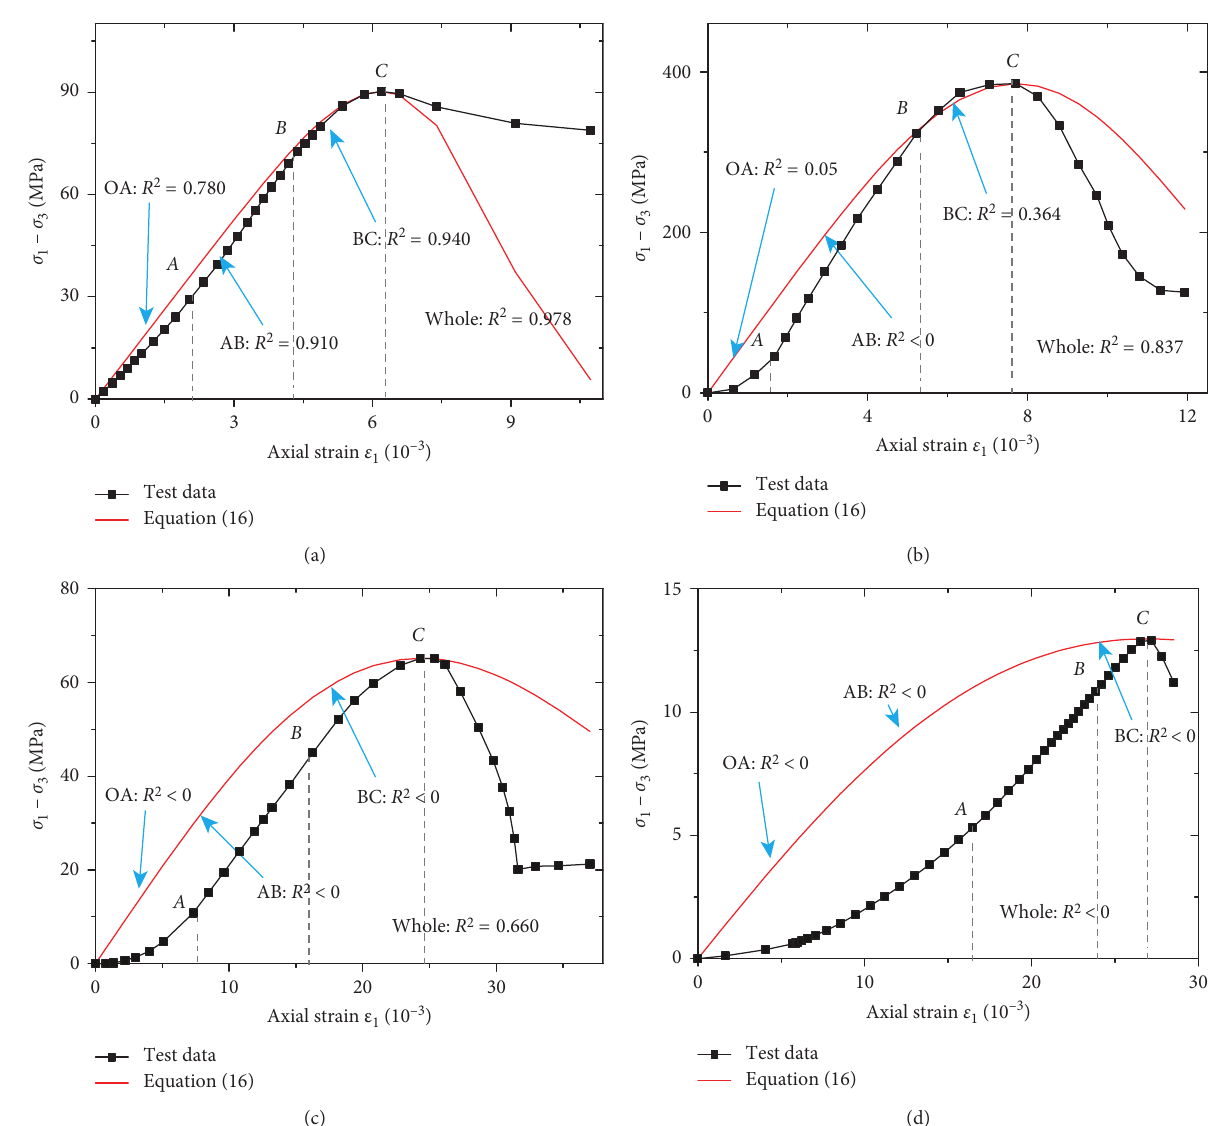
Figure 8: Fitting degree analysis of the statistical damage constitutive model from [26] (see (16)). (a) Altered rock [36] σ σ 3 � 12MPa. (b) Quartiz [37] σ c � 385MPa, σ 3 � 5MPa. (c) Coal [37] σ c � 65MPa, σ 3 � 8MPa. (d) Sandstone ( n � 21.1%) σ c � 12.97MPa, σ 3 �